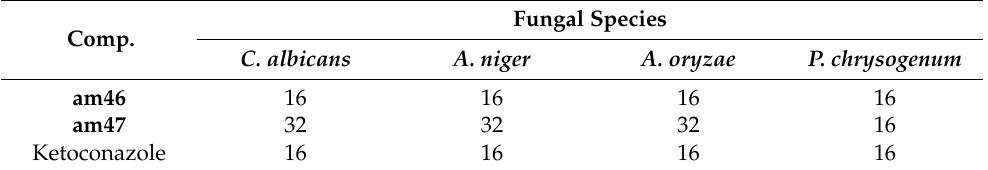
Table 21. Antifungal activity (MIC = µ g/mL) of the compounds ( am46 – am47 ). Comp.